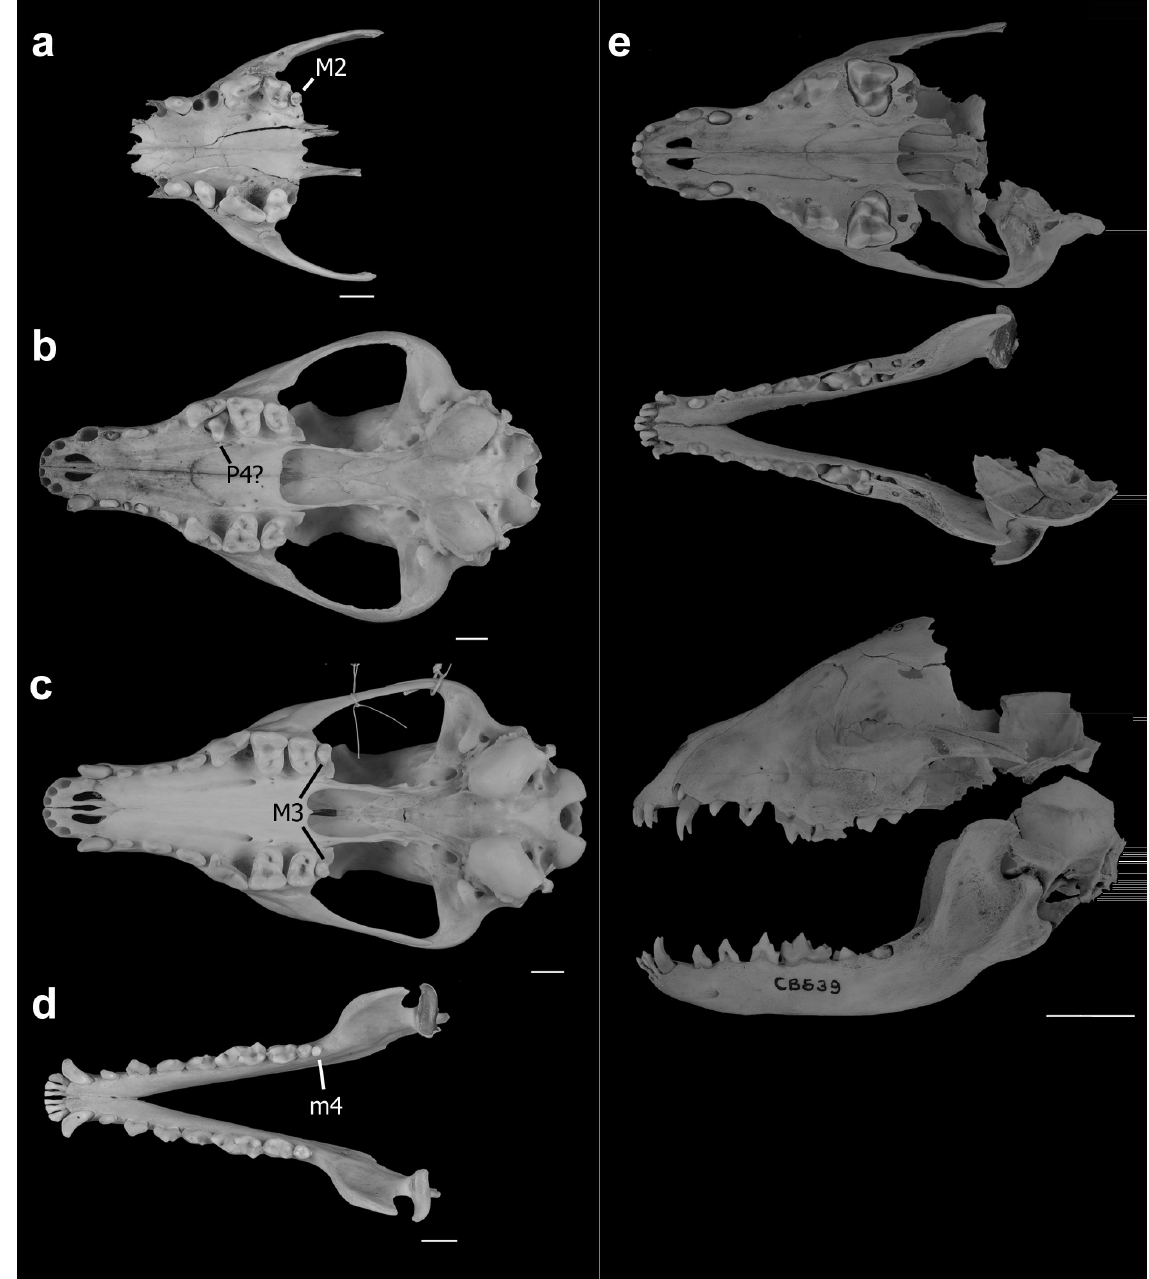
Figure 2. Canidae dentitions. a) Ventral view of a partial skull of Speothos venaticus (MN75089) with two upper molars instead of one; b) Ventral view of a Cerdocyon thous skull (MN79593) with an extra premolar positioned lingually to left carnassial; c) Ventral view of a C. thous skull (MN71092) with three upper molars instead of two; d) Mandible of C. thous (MN79393) in occlusal view with four lower molars on the right side and three on the left side; e) Occlusal (top) and lateral (bottom) views of a juvenile C. thous exemplar (MN81779) showing small pits positioned lingually to incisors, canines and premolars, through where permanent teeth would have erupted and replaced the deciduous ones. Note that P1 and P2, P3, P4 have unsynchronized eruptions, and dP3 and dP4 resemble a carnassial and a molar, respectively. Abbreviation “P” means premolars and “M” molars. Scale bar =